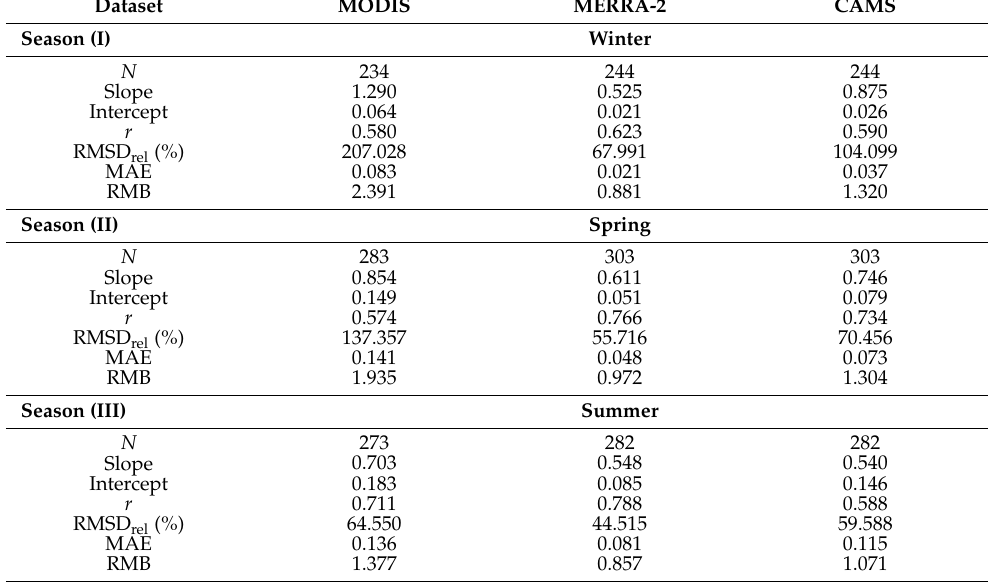
Table A3. AOD seasonal statistical parameters as derived from the comparison between MODIS, MERRA-2, CAMS and AERONET observations over